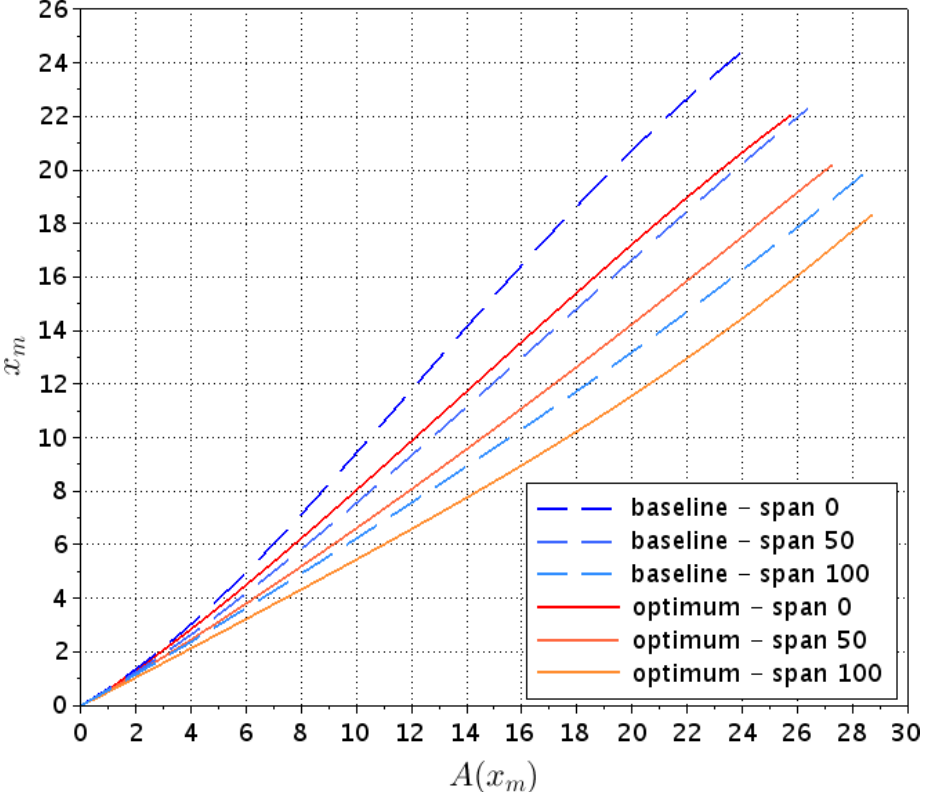
Figure 14. Profiles of the blade camberline in the conformal mapping plane for the baseline and optimized